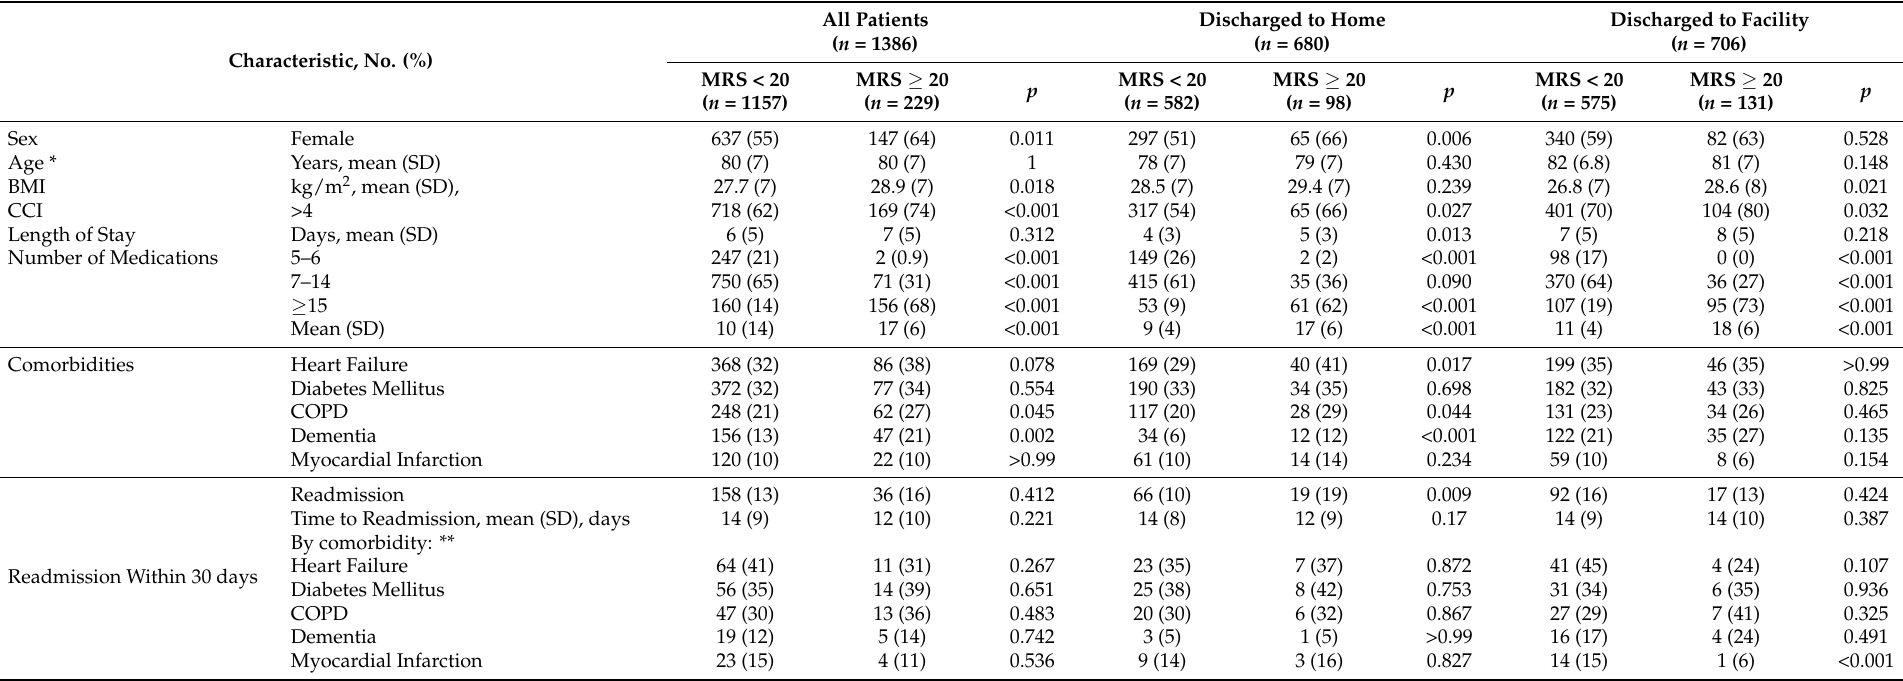
Table 2. Patient characteristics stratified by risk score and discharge